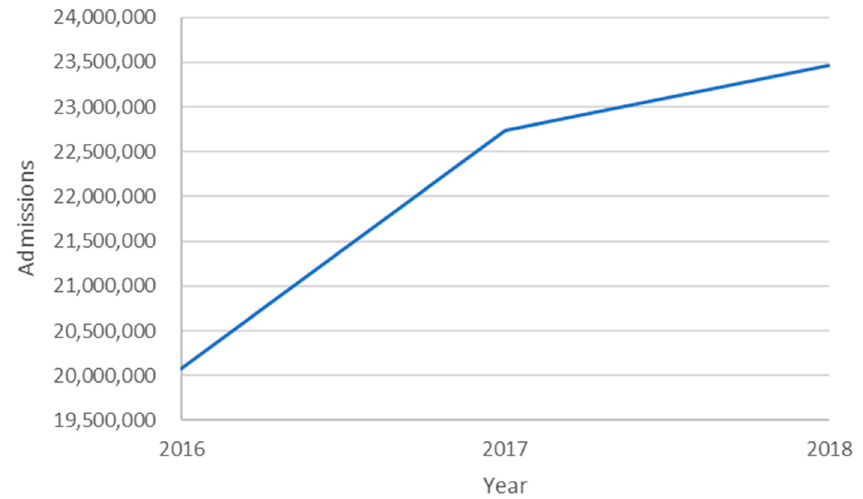
Figure 2. Number of DRGs as a function of year.